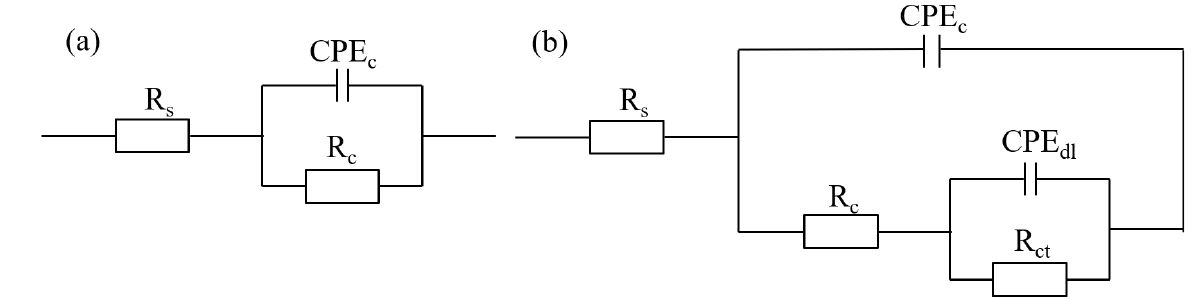
Figure 8. The equivalent circuit models of the first ( a ) and the second ( b ). Table 1. Electrochemical impedance data of neat and composite waterborne epoxy coatings.